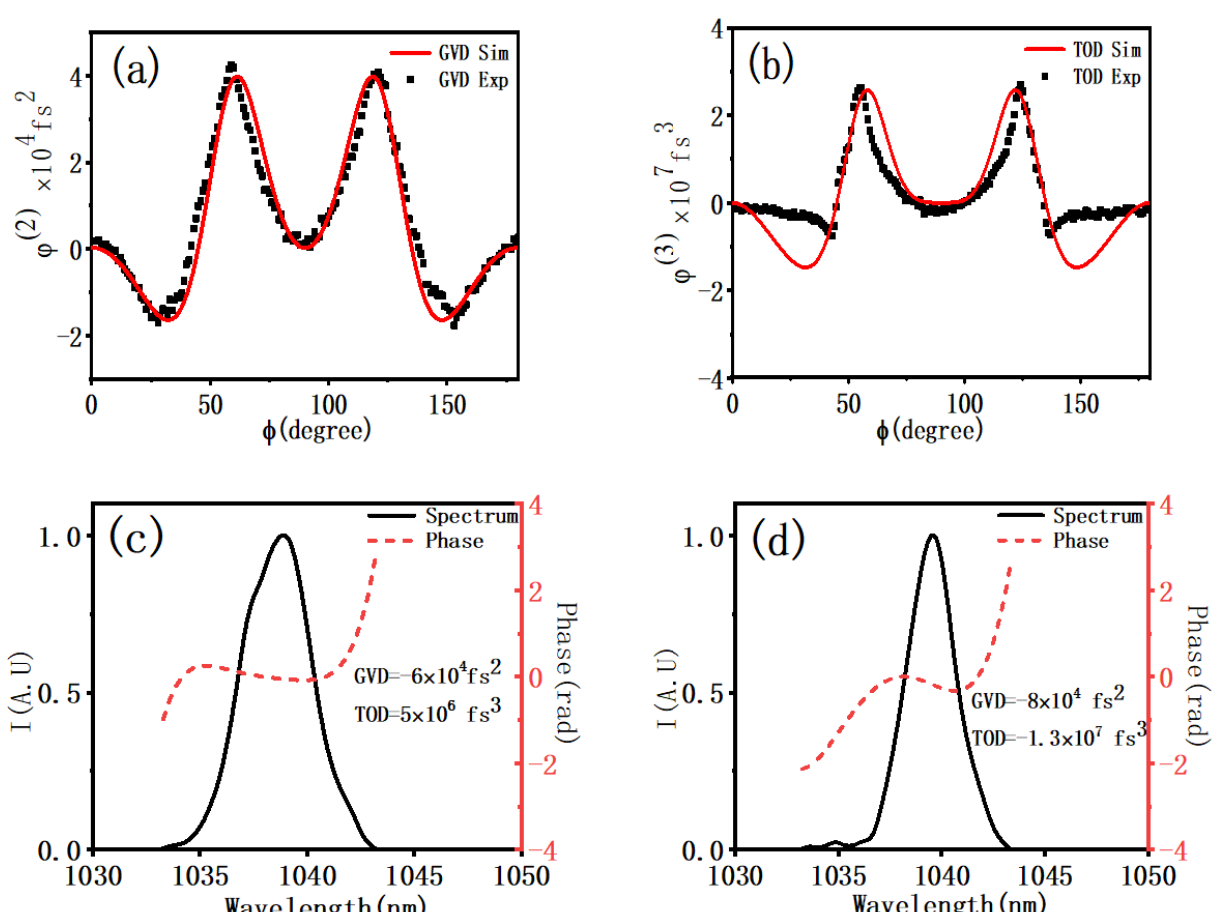
Figure 8. ( a ) Experimental measurement results of GVD represented by the dotted black line, compared with simulated results shown by the solid red line; ( b ) the measured and simulated TOD; ( c ) the initial spectral and phase measurement with the residual GVD of − 6 × 10 4 fs 2 and TOD of 5 × 10 6 fs 3 from the laser without inserting quartz; ( d ) the spectral and phase with the GVD of − 8 × 10 4 fs 2 and the TOD of − 1.3 × 10 7 fs 3 , according to the valleys in Figure ( b ).